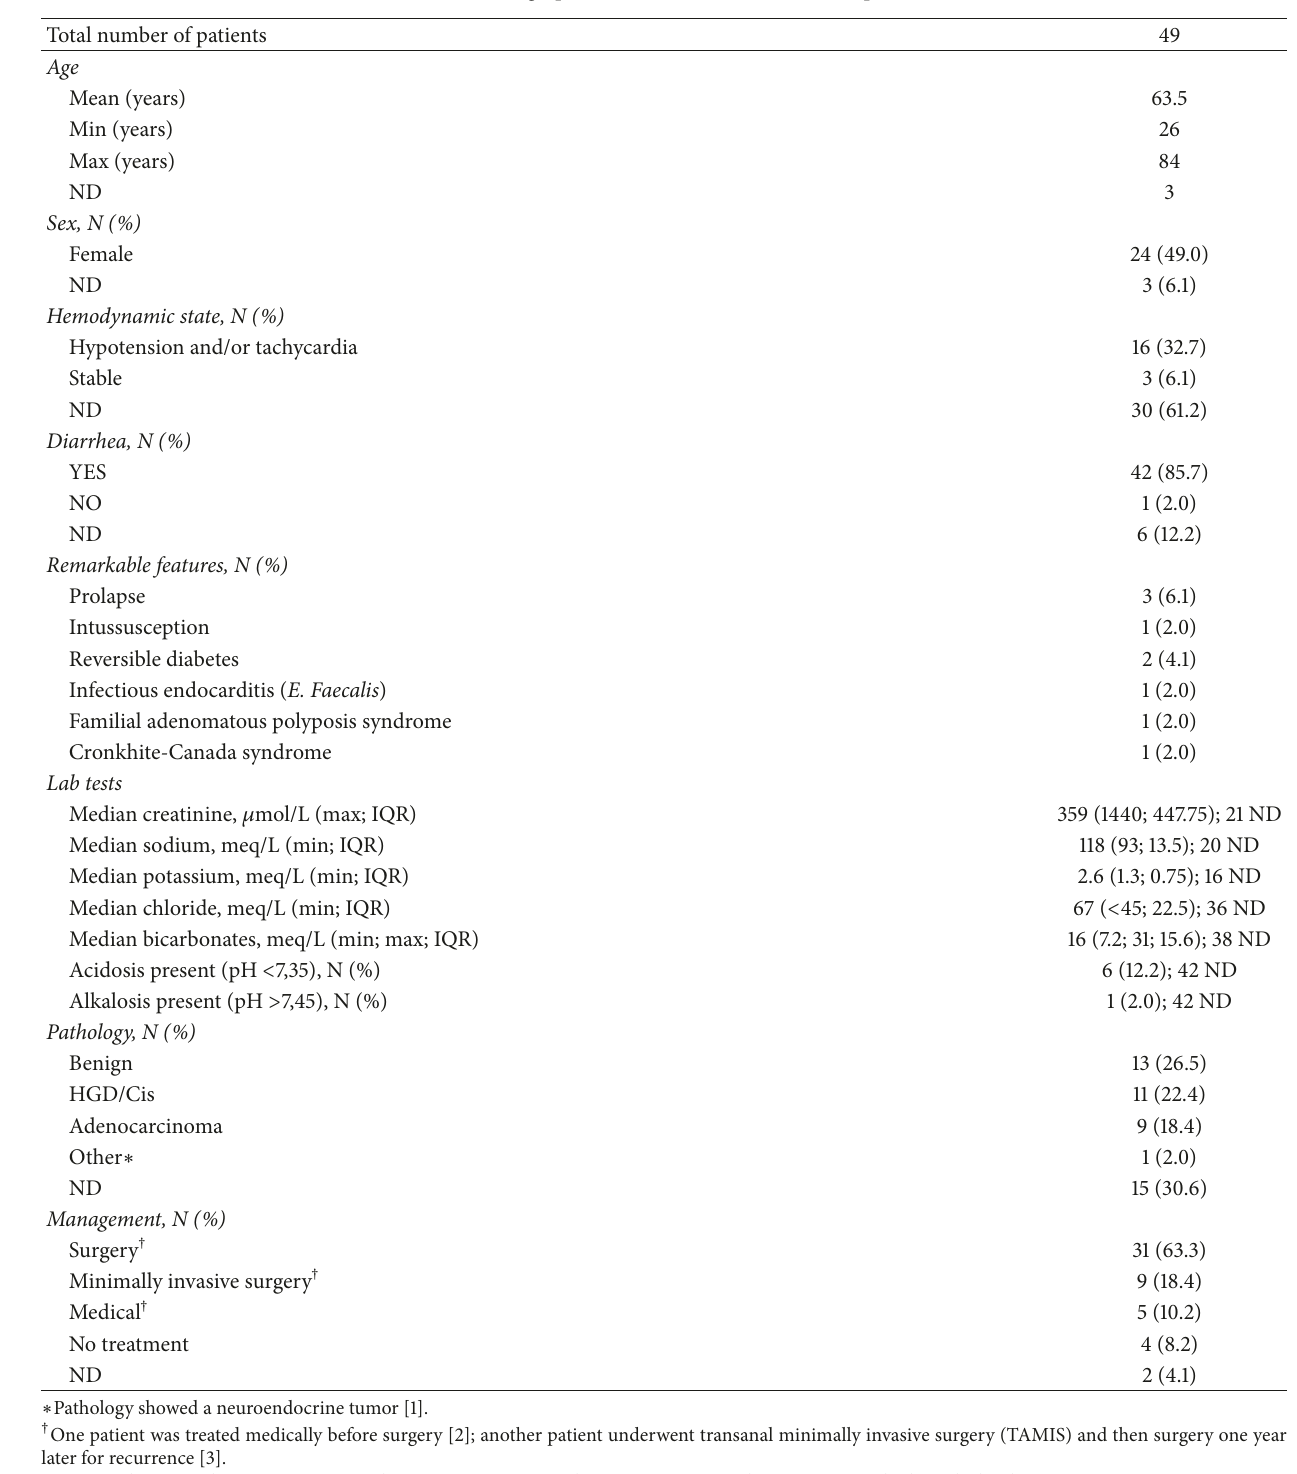
Table 2: Demographic and clinical characteristics of